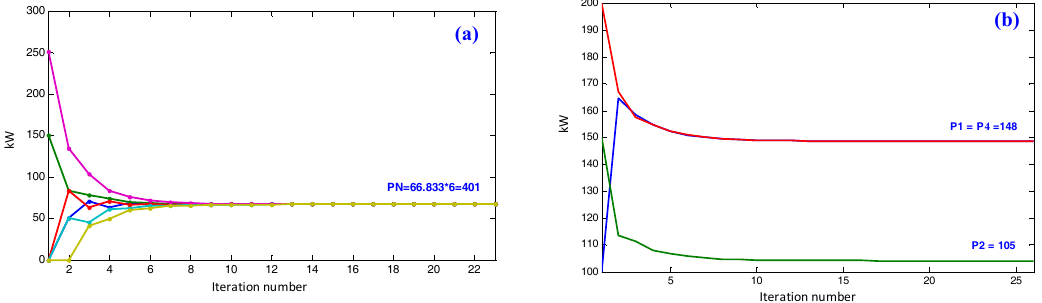
Figure 13. Operation results of isolated part at interval 10: ( a ) information sharing (shortage amount); and ( b ) distributed optimization.